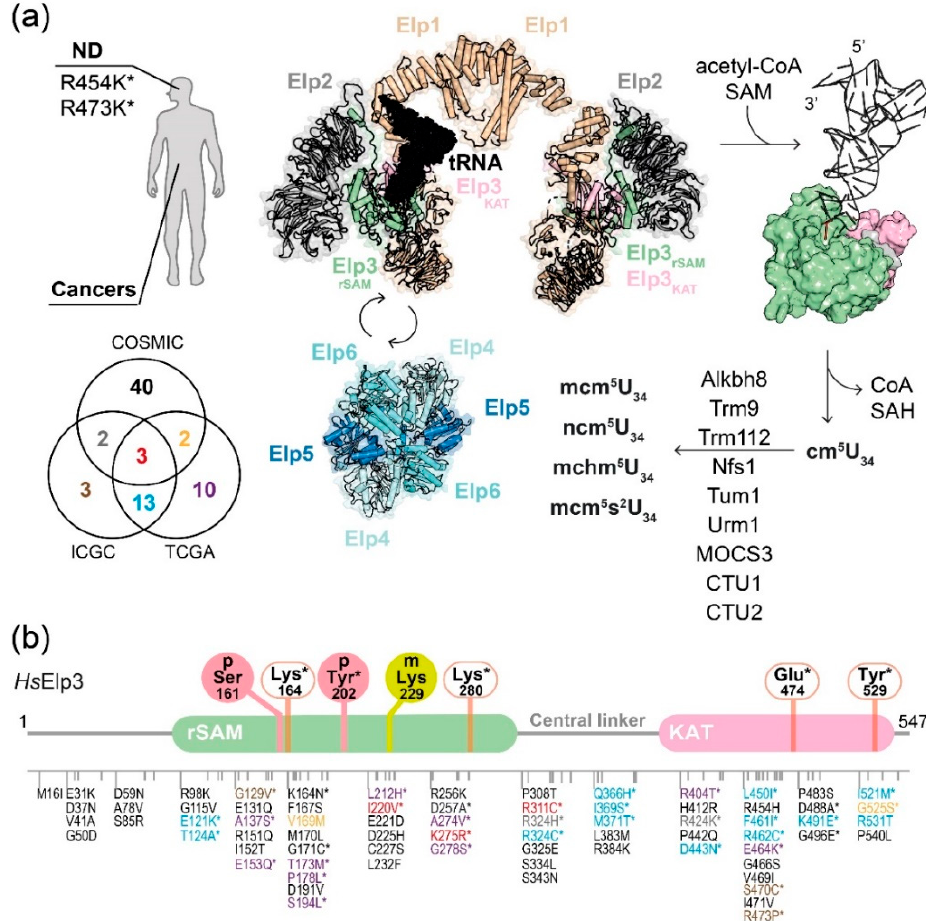
Figure 3. Elongator-mediated tRNA modification and clinically relevant mutations of human Elp3. ( a ) Schemes of disease-related mutations and Elongator-mediated tRNA modification cascade. The reported changes in human Elp3 from neurodegenerative diseases (ND) are indicated, while those of tumors (data were retrieved from COSMIC, ICGC, and TCGA databases) are shown in the Venn diagram. tRNA (black) binds to one lobe of Elp123 that is involved in Elp456 dynamic interactions. Elp3 hydrolyzes acetyl-CoA and cleaves SAM for the cm 5 addition on U 34 . The cm 5 U 34 is then converted to the derivatives by other enzymes. ( b ) Summary of reported alterations and PTM sites of mouse Elp3 (p-Ser161) and human Elp3 (p-Tyr202 and m-Lys229). The residue numbers and domains of human Elp3 are indicated. The locations of the alterations are as listed in the cartoon representation and they are color-coded according to which database resources are found. The experimentally verified residues are indicated with an asterisk. The identified PTM sites (solid circles) of Elp3 as well as the catalytic residues for acetyl-CoA binding/hydrolysis (open square) in Elp3 are listed.